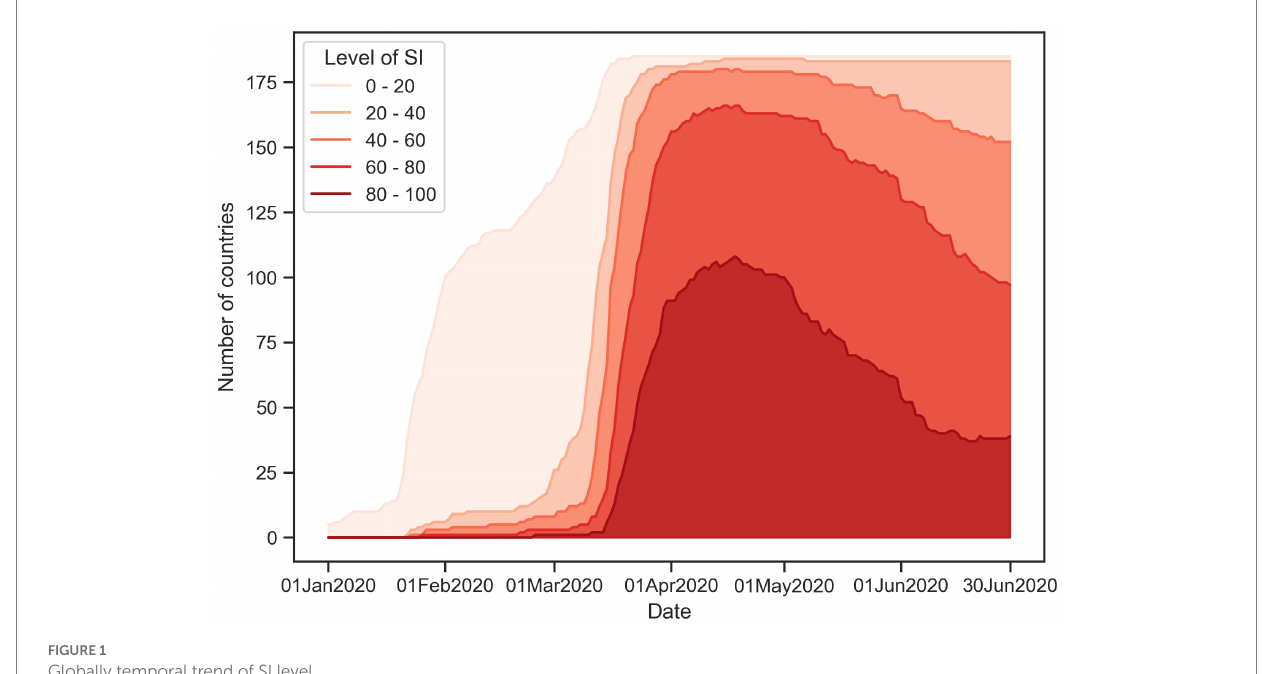
FIGURE 1 Globally temporal trend of SI